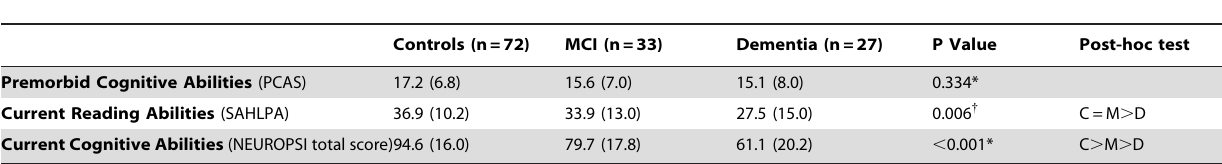
Table 4. Between-group comparison of mean PCAS scores and construct